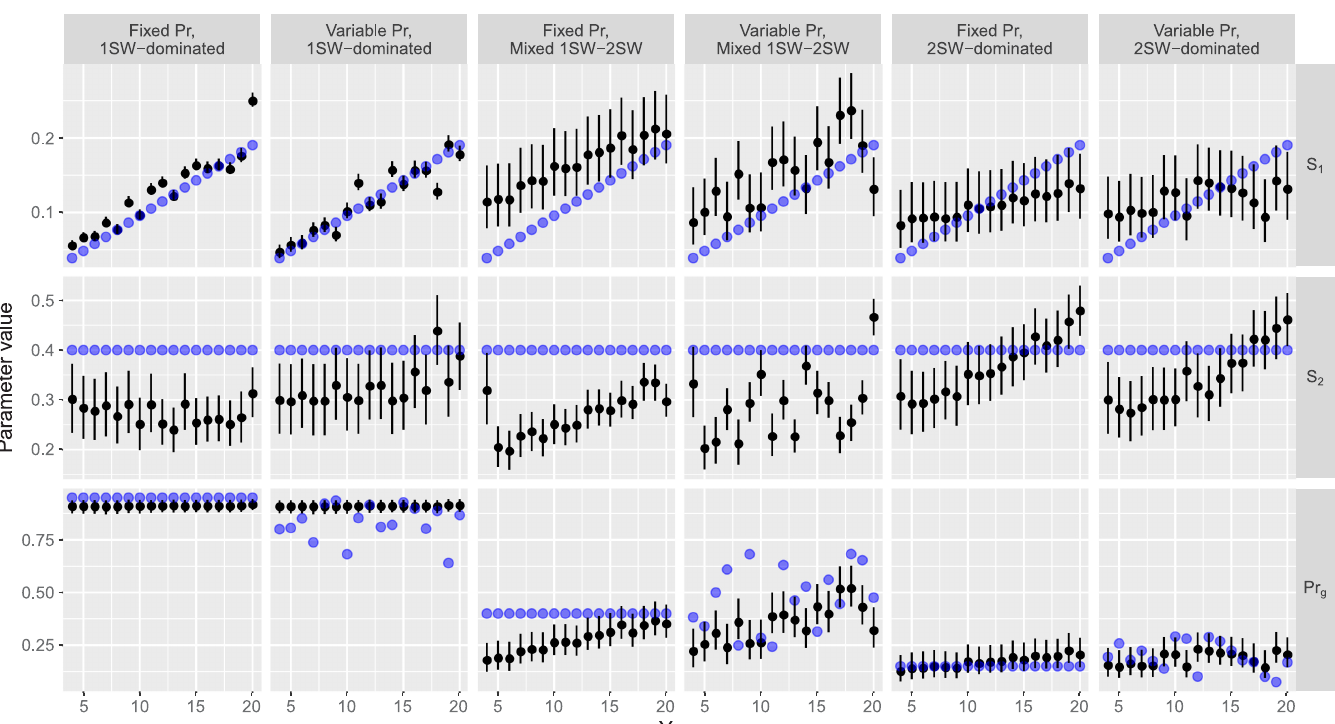
Fig 2. Yearly estimated S 1 , S 2 , and P values in the six scenarios. True values are denoted by blue circles, black circles show median estimates, error bars indicate the r 25% and 75% quantiles.